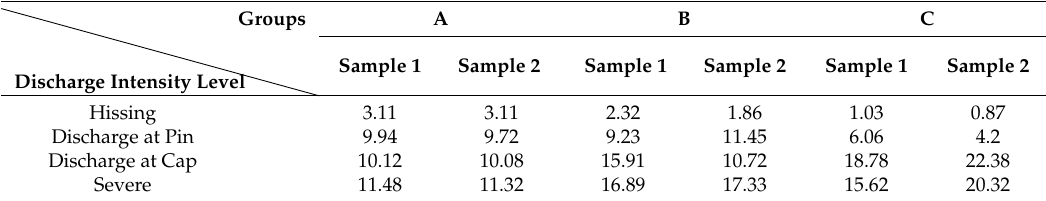
Table 16. Average THD (%) for wet condition.